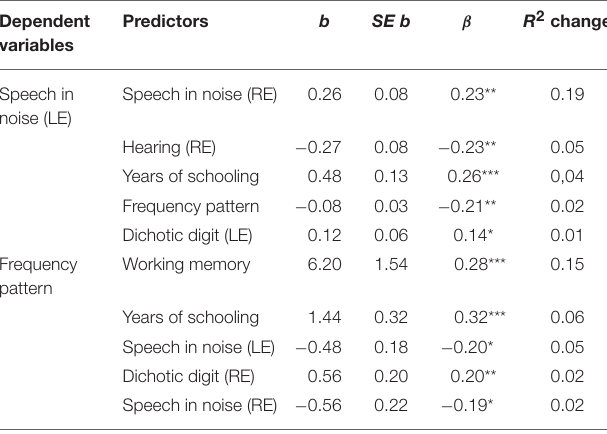
TABLE 2 | Final regression